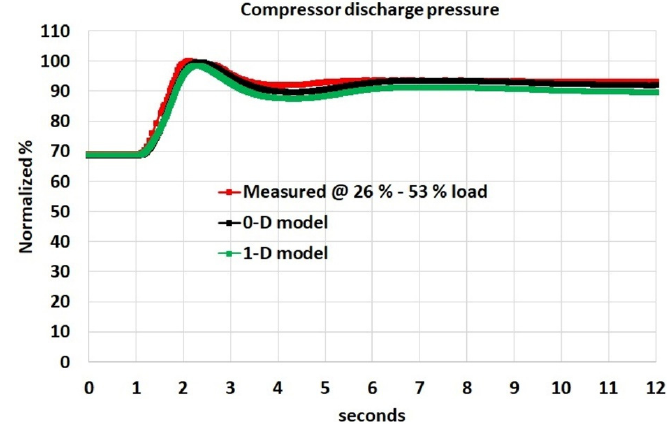
Figure 10. Compressor discharge pressure with increasing load from 26% to 53% of the maximum load and considering bleed.